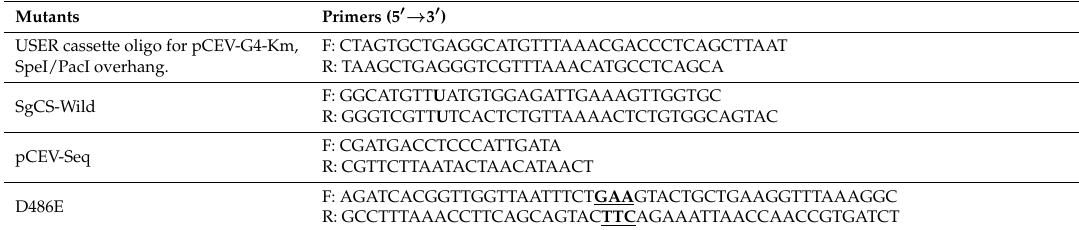
Table A2. List of primer